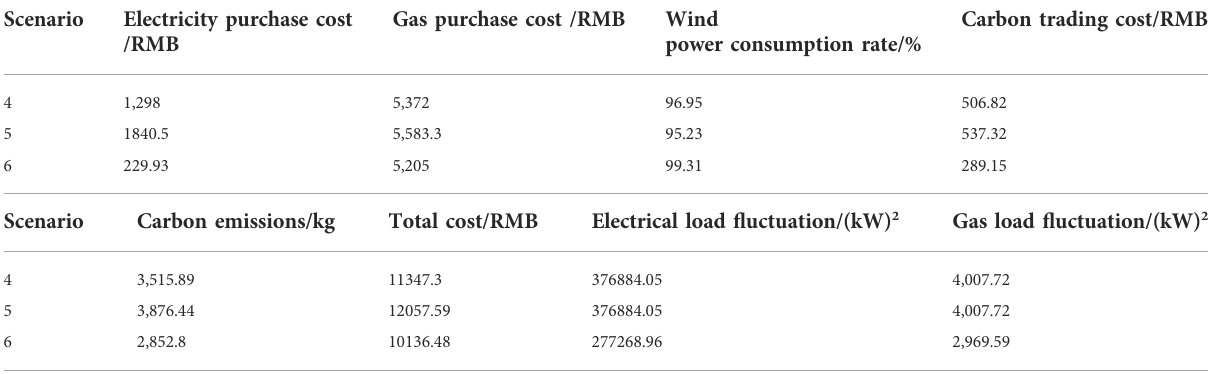
TABLE 5 Comparison of the results of scenarios 4,5, and 6